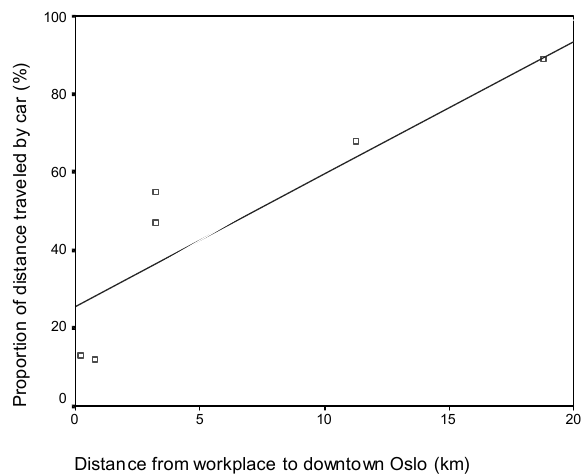
Figure 7. Average proportions of commuting distance travelled by car among employees at workplaces located in different distances from downtown Oslo. Per cent. N = 465 employees at 6 workplaces. relationship: 0.000. Source: Naess and Sandberg